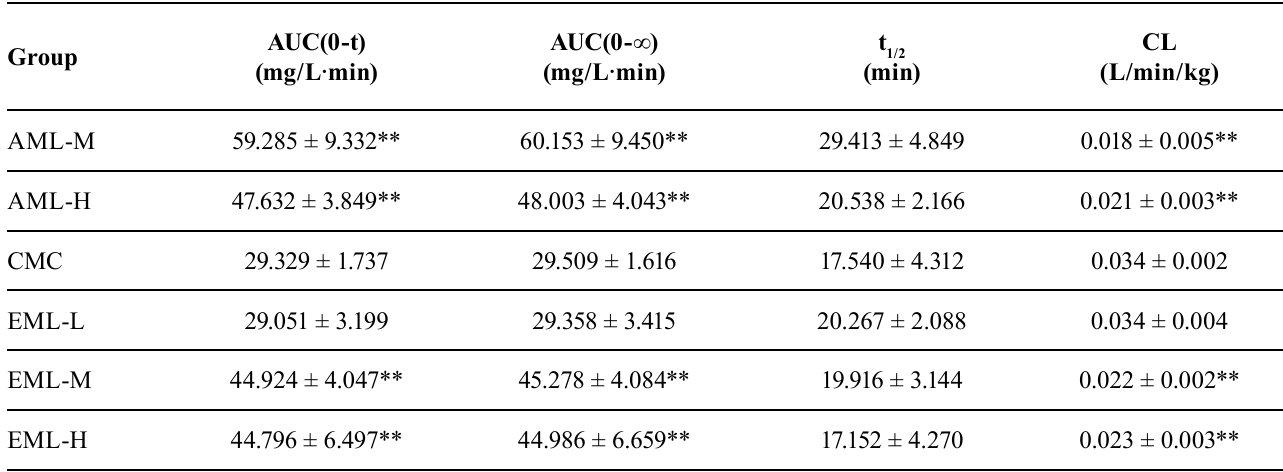
TABLE IV – Main pharmacokinetic parameters of phenacetin in rats (n=6, mean ± SD)